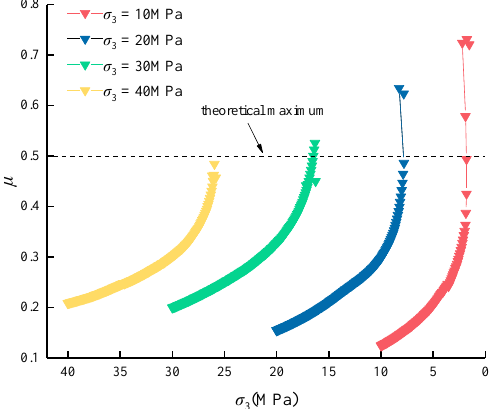
Figure 5. Relationship between Poisson’s ratio and confining stress during unloading.